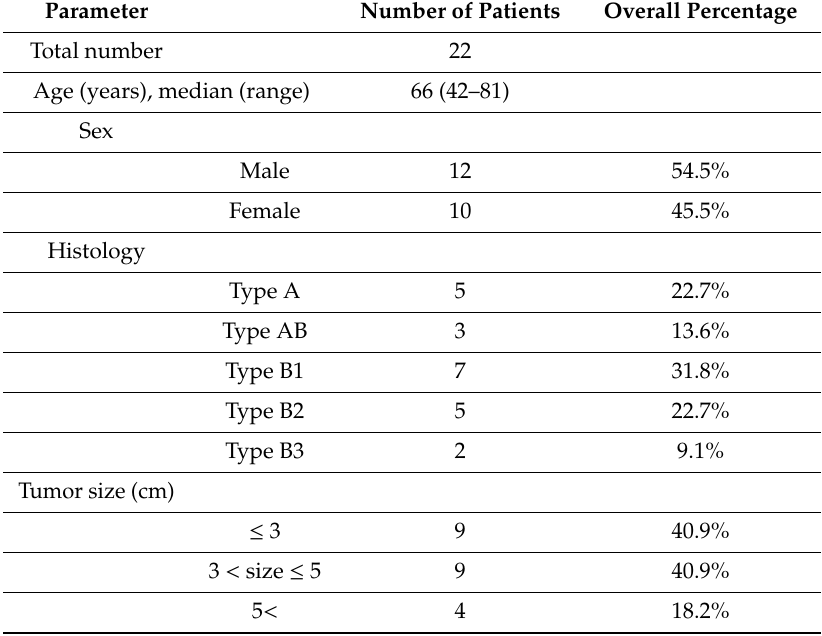
Table 1. Patient